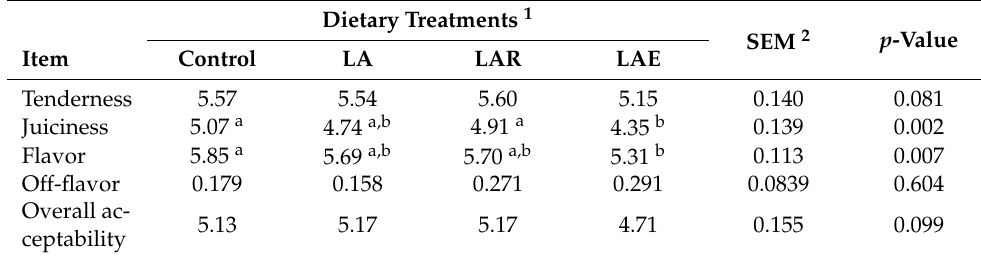
Table 5. Sensorial attributes of broiler breast meat ( n = 10).